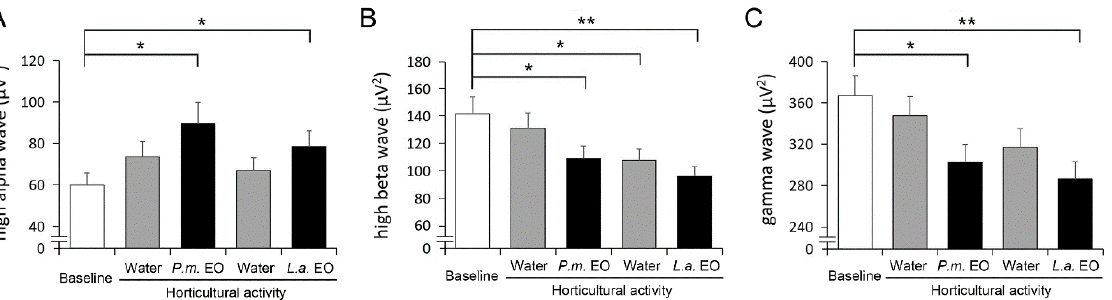
Figure 3. The brain-waves-related physiological parameters. After the baseline period, an indoor horticultural activity, leaf printing, was introduced. In the meantime, water vapor (water), water vapor with Pseudotsuga menziesii essential oil ( P.m. EO), water vapor (water), and water vapor with Lavandula angustifolia essential oil ( L.a. EO) were diffused into the air in an orderly manner. The values of high alpha wave increased during the diffusion of both EOs ( A ). The values of high beta wave decreased while EOs were given ( B ). The gamma wave was reduced while breathing EOs ( C ). Data were collected from 92 participants and presented as mean ± SE. *, p < 0.05; **, p < 0.01, Wilcoxon signed-rank test.